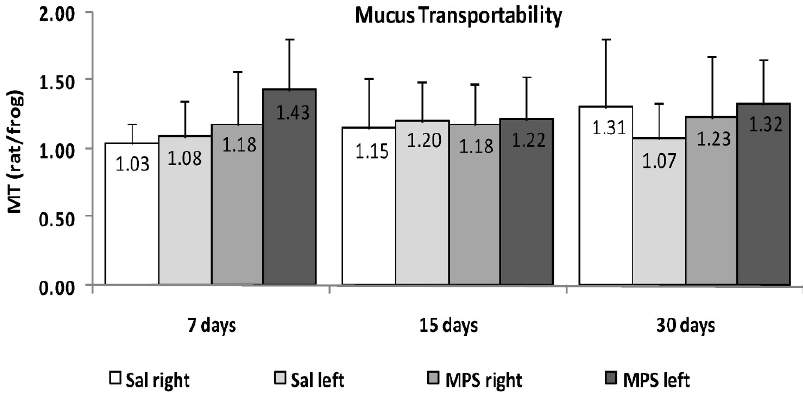
Figure 1 - Mucociliary transportability (MT and rat/frog) of mucus samples obtained from the left (operated) or right (intact) bronchi of rats treated with saline (Sal) or mycophenolate sodium (MPS) for 7, 15, or 30 days ( p . 0.05).